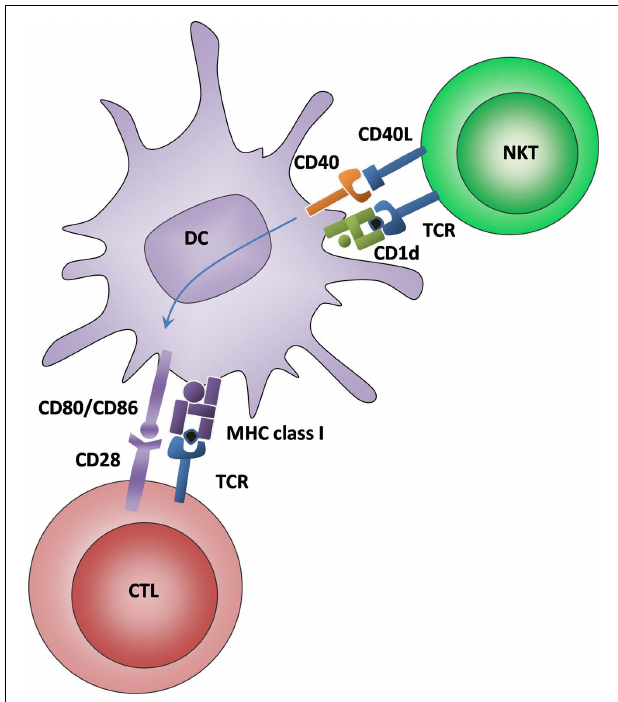
FIGURE 2 |Alternative DC licensing for cross-priming is mediated by NKT cells recognizing glycolipid antigens. DCs interact with NKT cells via glycolipid antigen that is presented on CD1d and recognized by an invariantTCR. Moreover, CD40–CD40L interactions lead to an upregulation of costimulatory molecules for CTL